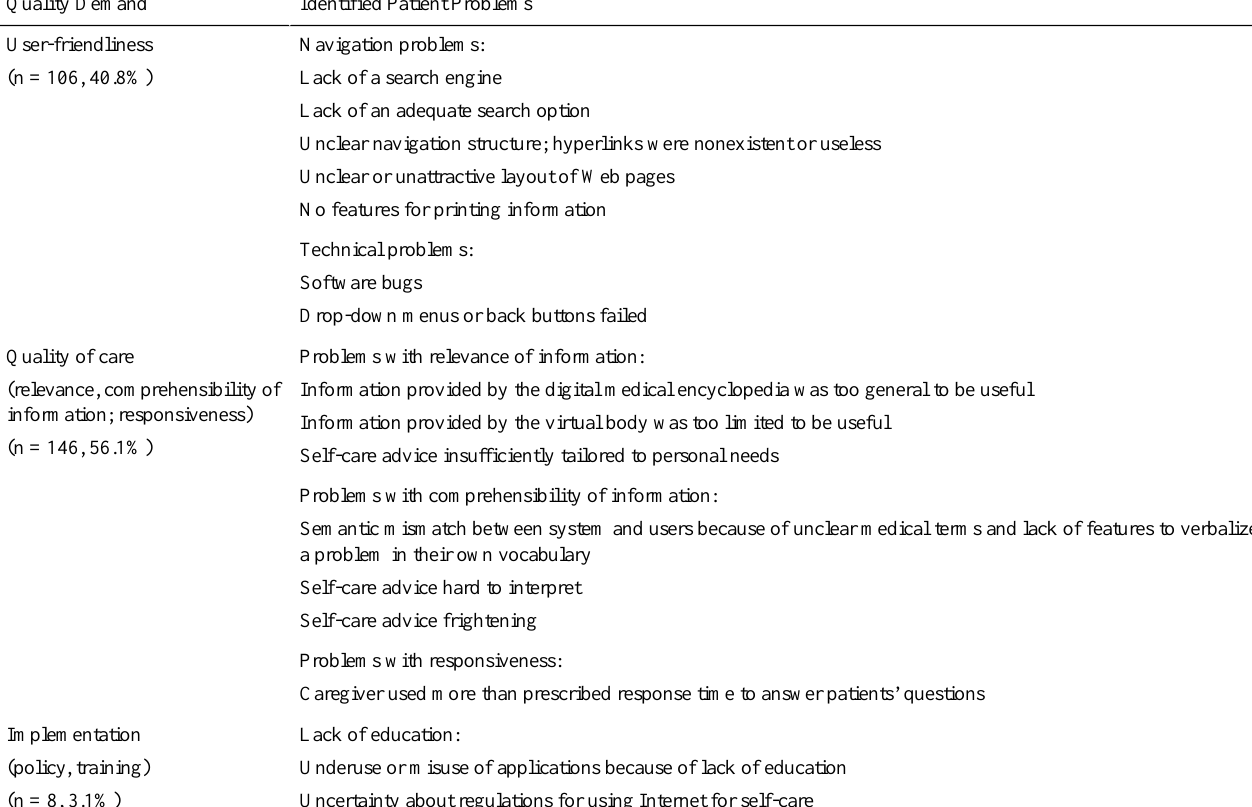
Identified Patient ProblemsQuality